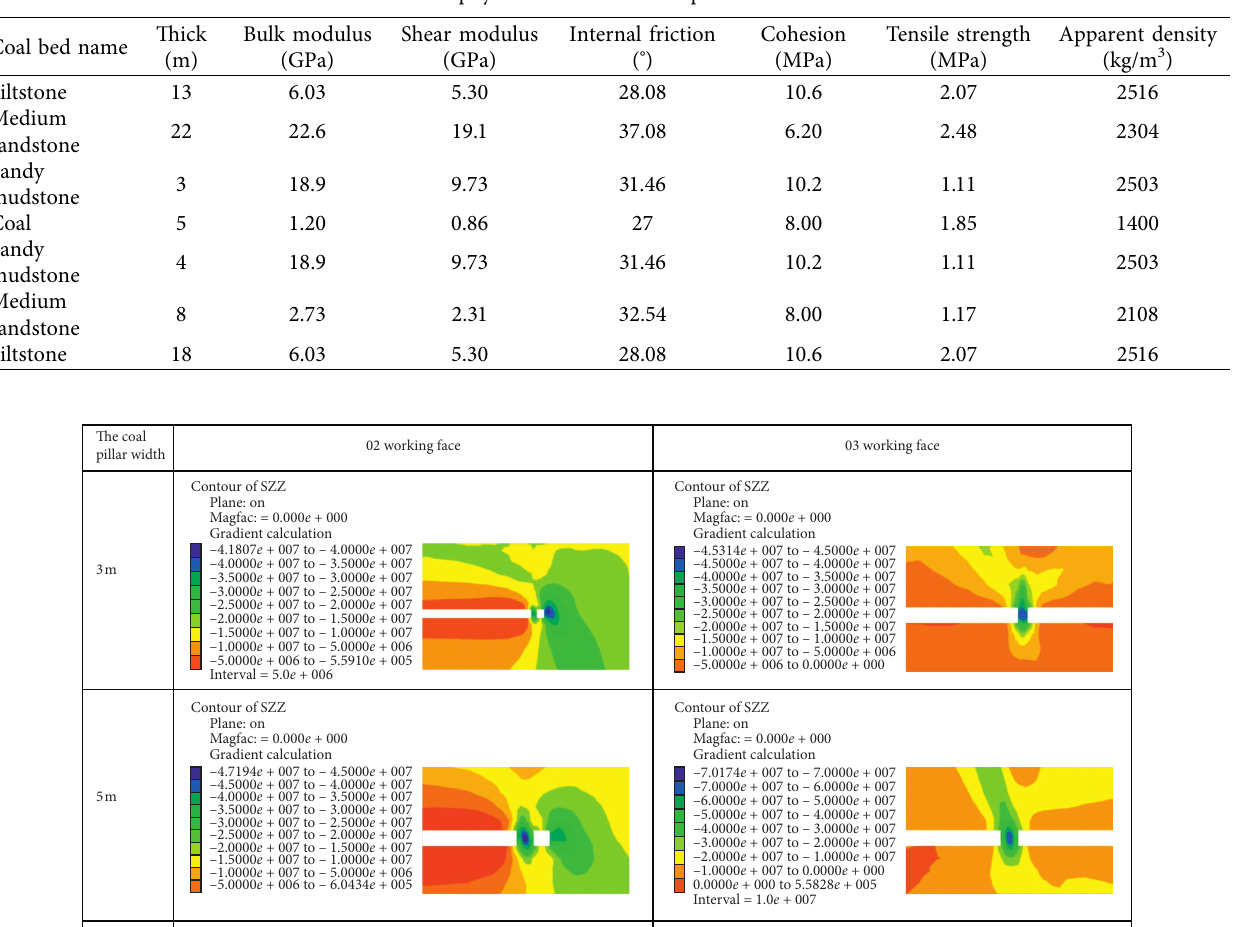
Table 4: Table of physical and mechanical parameters of coal